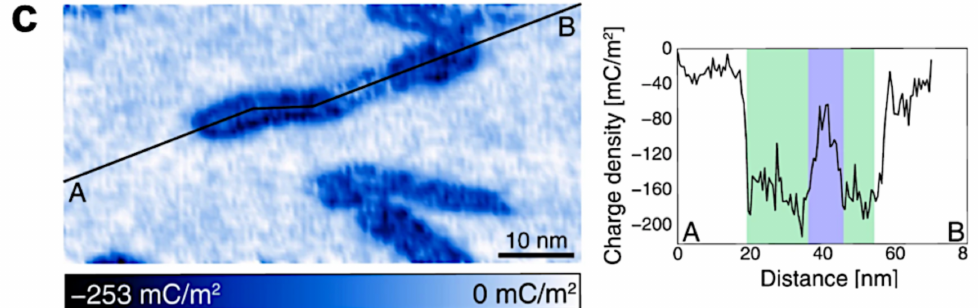
Figure 8. ( a ) 3D frequency shift map; ( b ) constant ∆ f image corresponding to topography image, ( c ) charge density map of DNA strand with B–Z junctions. The height and charge density profiles are extracted along the lines marked on corresponding maps. Images reproduced under the CC BY license from Kominami, H., Sci. Rep. ; published by Springer Nature, 2019.